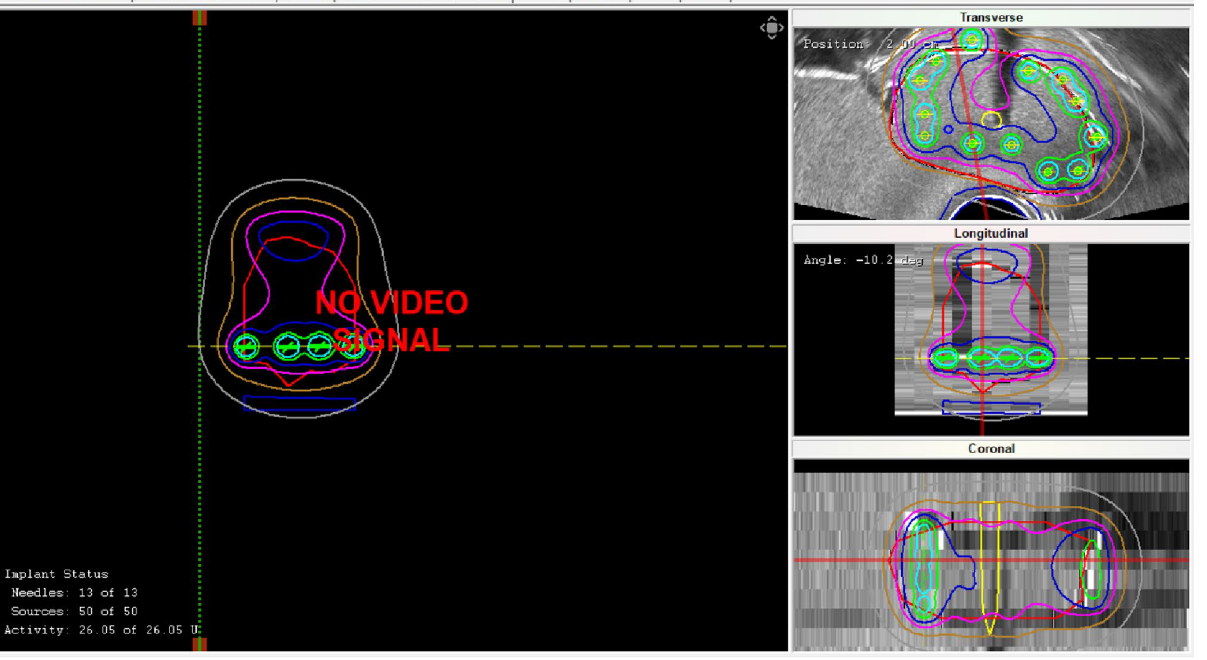
Figure 3. 3D anthropomorphic phantom treatment plan in the VariSeed TPS. Post-implant dosimetry analysis displaying transverse, longitudinal, and coronal views (without live video signal): I-125 seeds (green), prostate (red), urethra (yellow), and isodose lines are